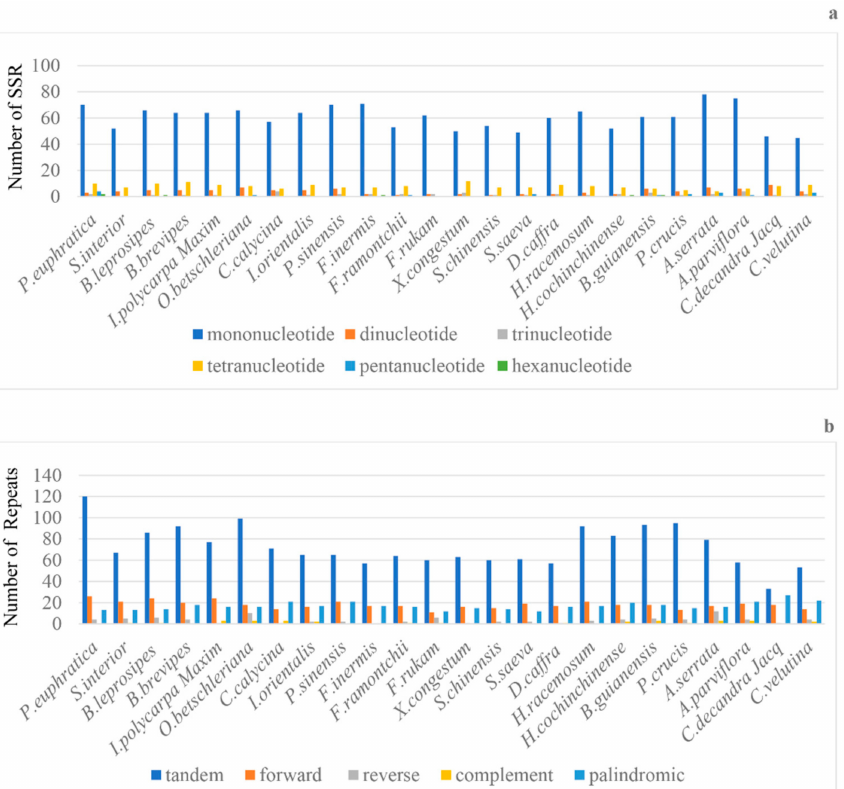
Figure 2. Comparison of repeat sequences among 24 plastomes. The X -axis represents the species and the Y -axis represents the number of repeats. ( a ) Frequency of selected motifs of simple sequence repeats (SSRs) and ( b ) number of each repeat type: tandem repeats, forward repeats, palindromic repeats, reverse repeats, and complement